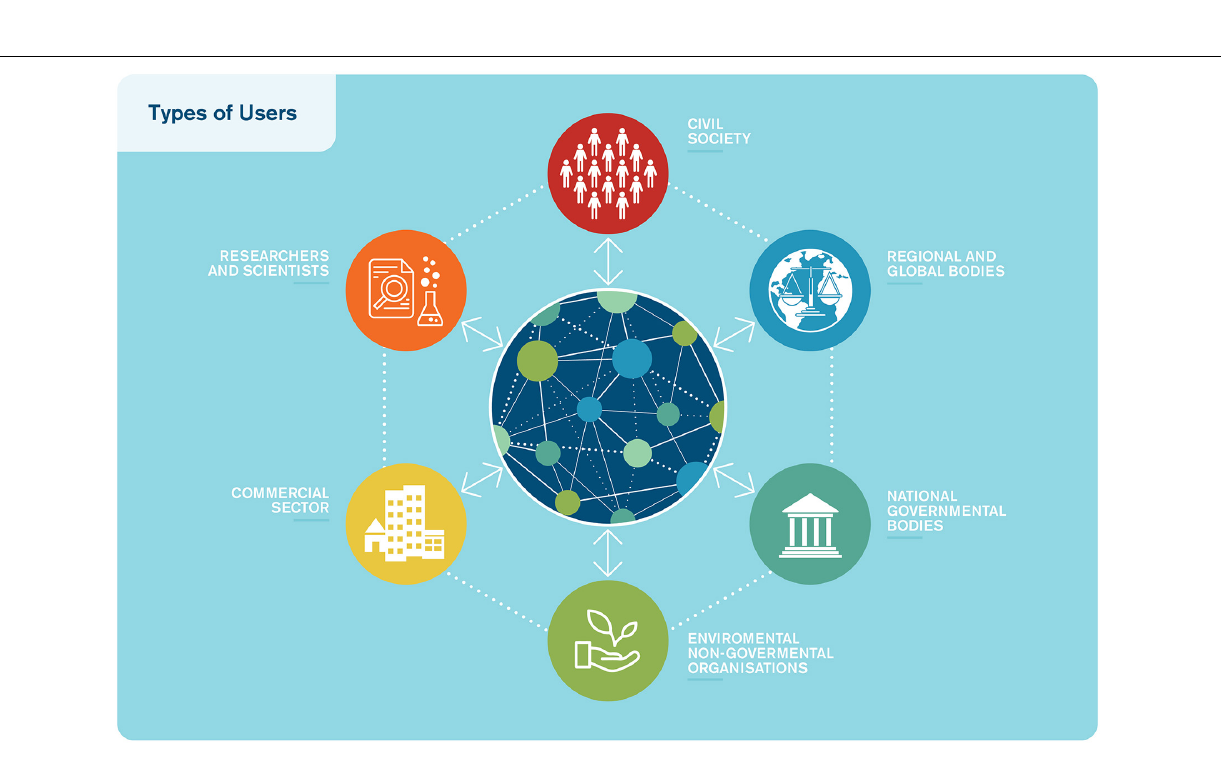
Frontiers in Marine Science |